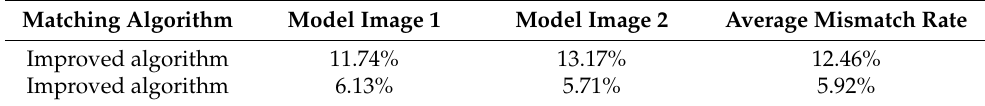
Table 4. Corresponding error-matching rate of the improved algorithm.